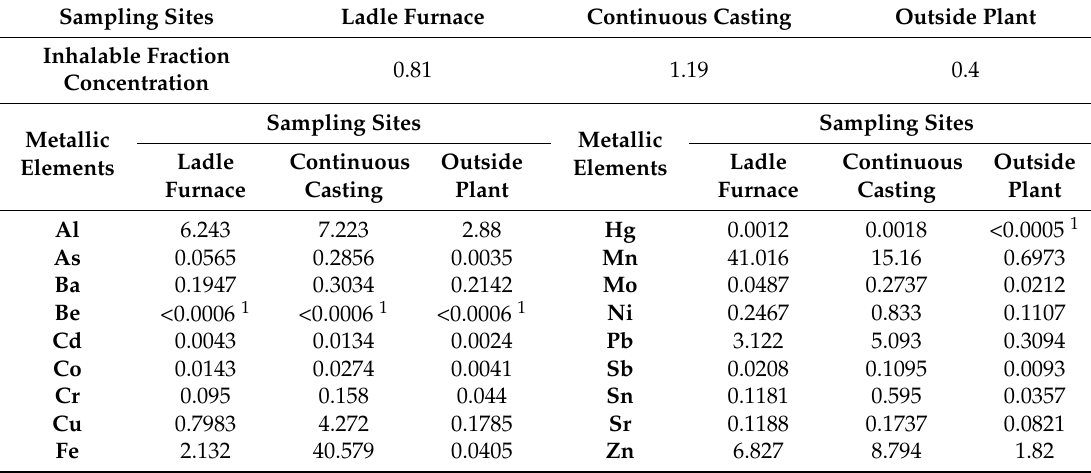
Table 1. Concentrations of the inhalable fraction (mg/m 3 ) and chemical composition of the particulate collected analyzed by inductively coupled plasma mass spectrometry (ICP-MS), expressed as concentrations ( µ g/m 3 ) of the metallic elements (ME) obtained from sampling in the ladle furnace, continuous casting, and outside the